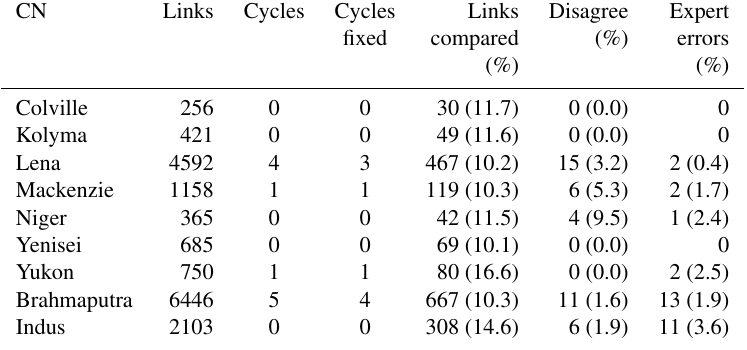
Table 1. Channel network properties and errors of the recipes. The percent of links compared is the fraction of total links for each CN. The disagreement and expert error percentages are fractions of the links compared. CN Links Cycles Cycles Links Disagree Expert fixed compared (%)